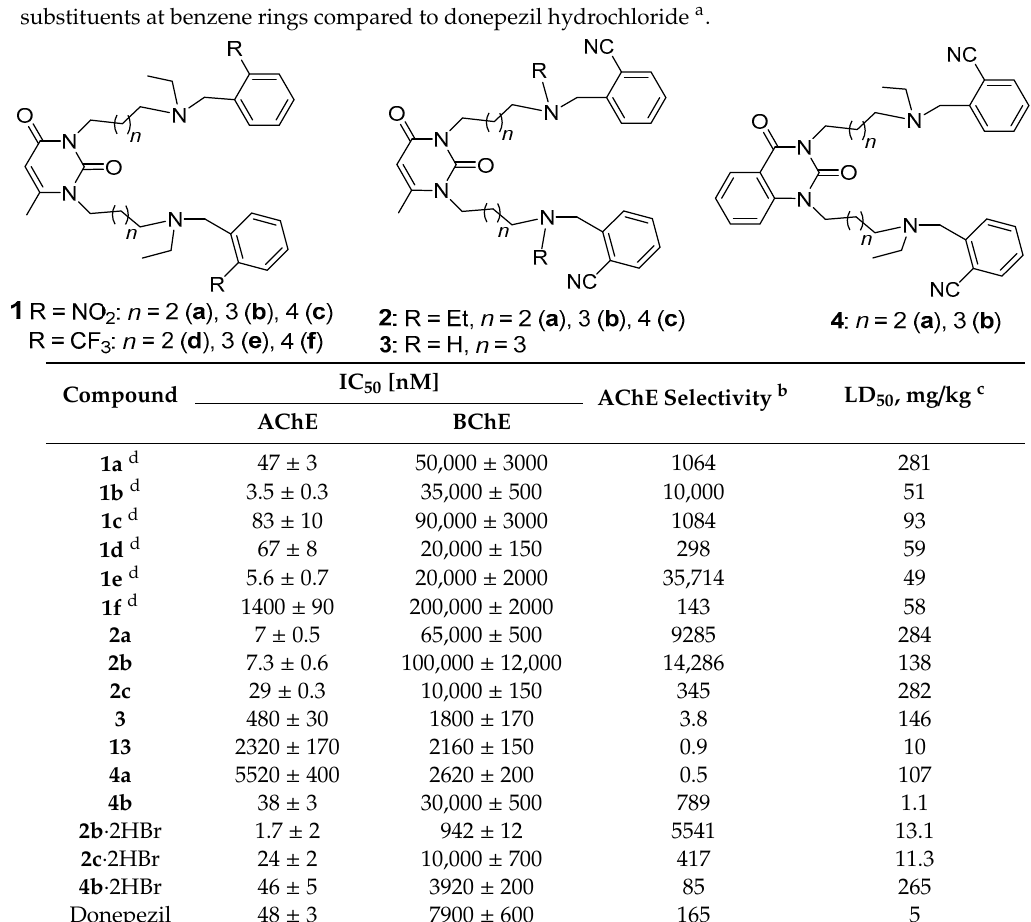
Table 1. In vitro inhibition of AChE from human erythrocytes and serum hBChE by compounds with 6-methyluracil, quinazoline-2,4-dione moieties, varied polymethylene chains, amino groups, and substituents at benzene rings compared to donepezil hydrochloride a .